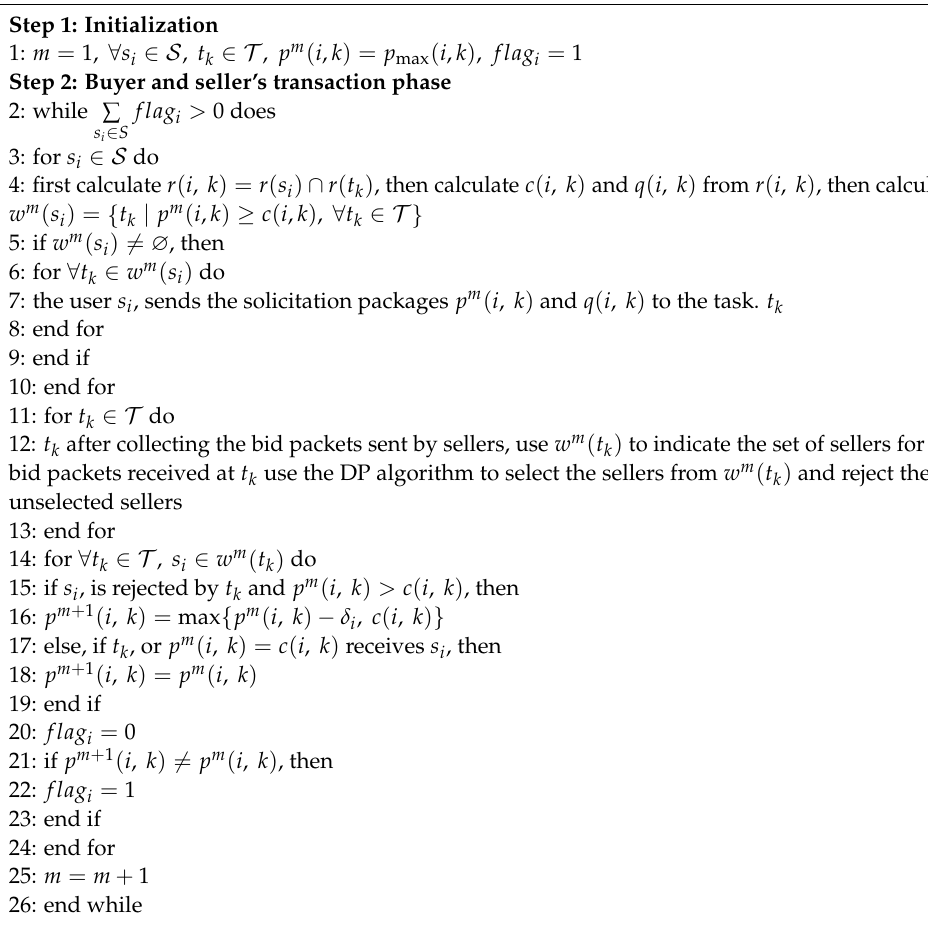
Algorithm 3: Stable task assignment algorithm with adjustable